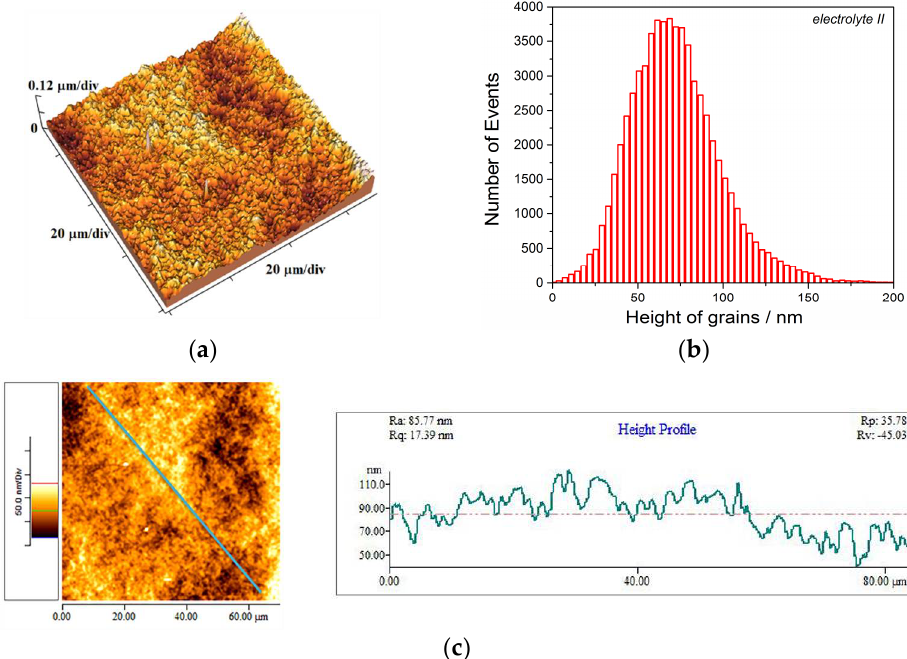
Figure 9. The AFM analysis of 40 µm thick Cu coating obtained by electrodeposition at a current density of 50 mA cm -2 on the Si(111) substrate from electrolyte II : ( a ) the surface topography, ( b ) the histogram and ( c ) line section analysis (X-axis: distance line; Y-axis: height profile). Scan size: (70 × 70) µm 2 .